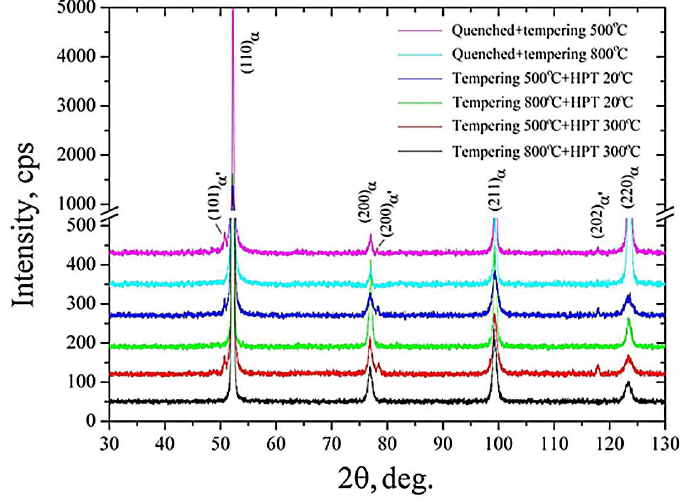
Figure 6. X-ray diffraction patterns of the Grade 91 steel after various treatments.